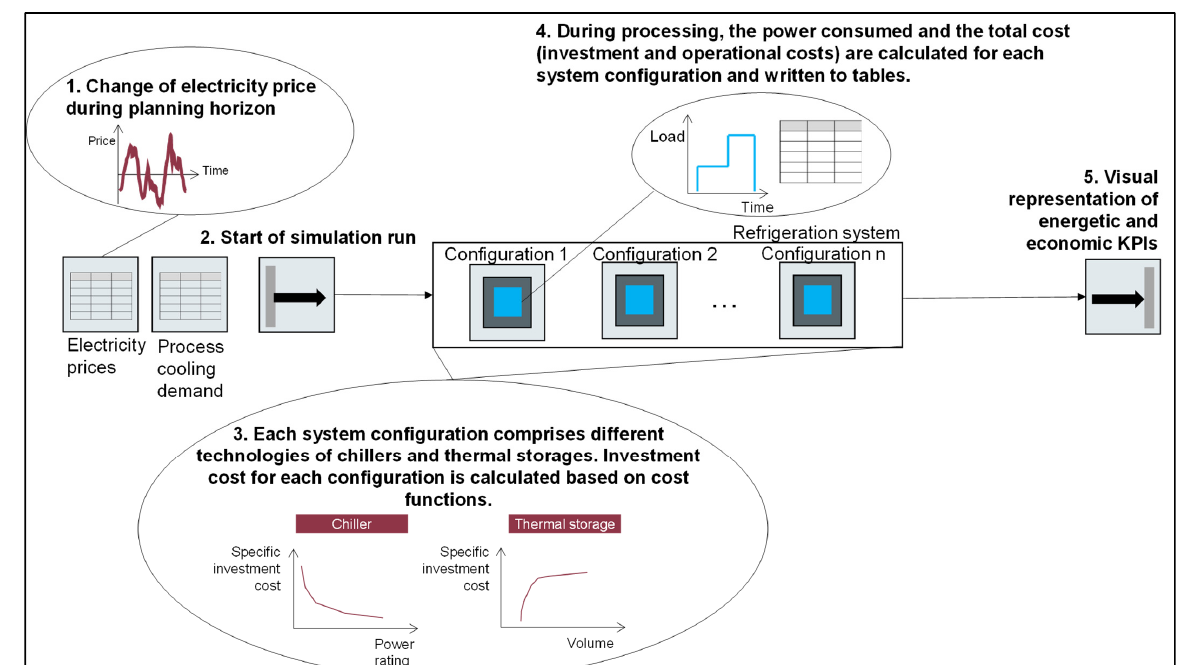
Figure 6. Schematic representation of the energy flow in use case 3.